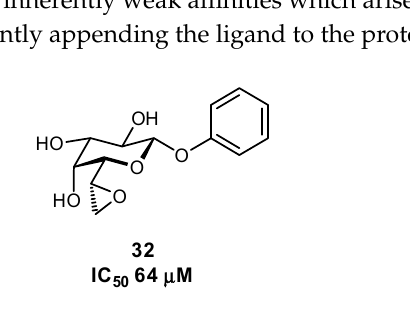
Figure 10. The first reported covalent lectin inhibitor, targeting Pseudomonas aeruginosa LecA [74].